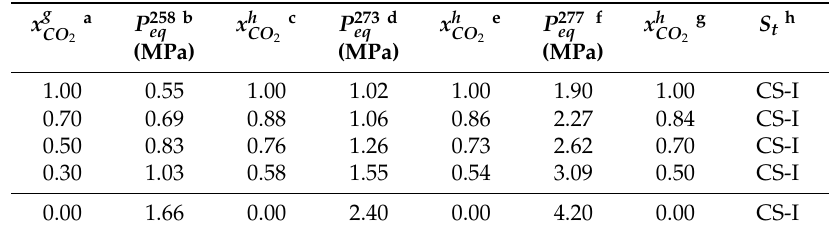
Table 1. P-T-x equilibria of ice (water)–gas–hydrate systems for the CO 2 + CH 4 gas mixture. a P 258 b c P 273 d e P 277 f x g x h x h eq eq eq CO 2 CO 2 CO 2 (MPa) (MPa)